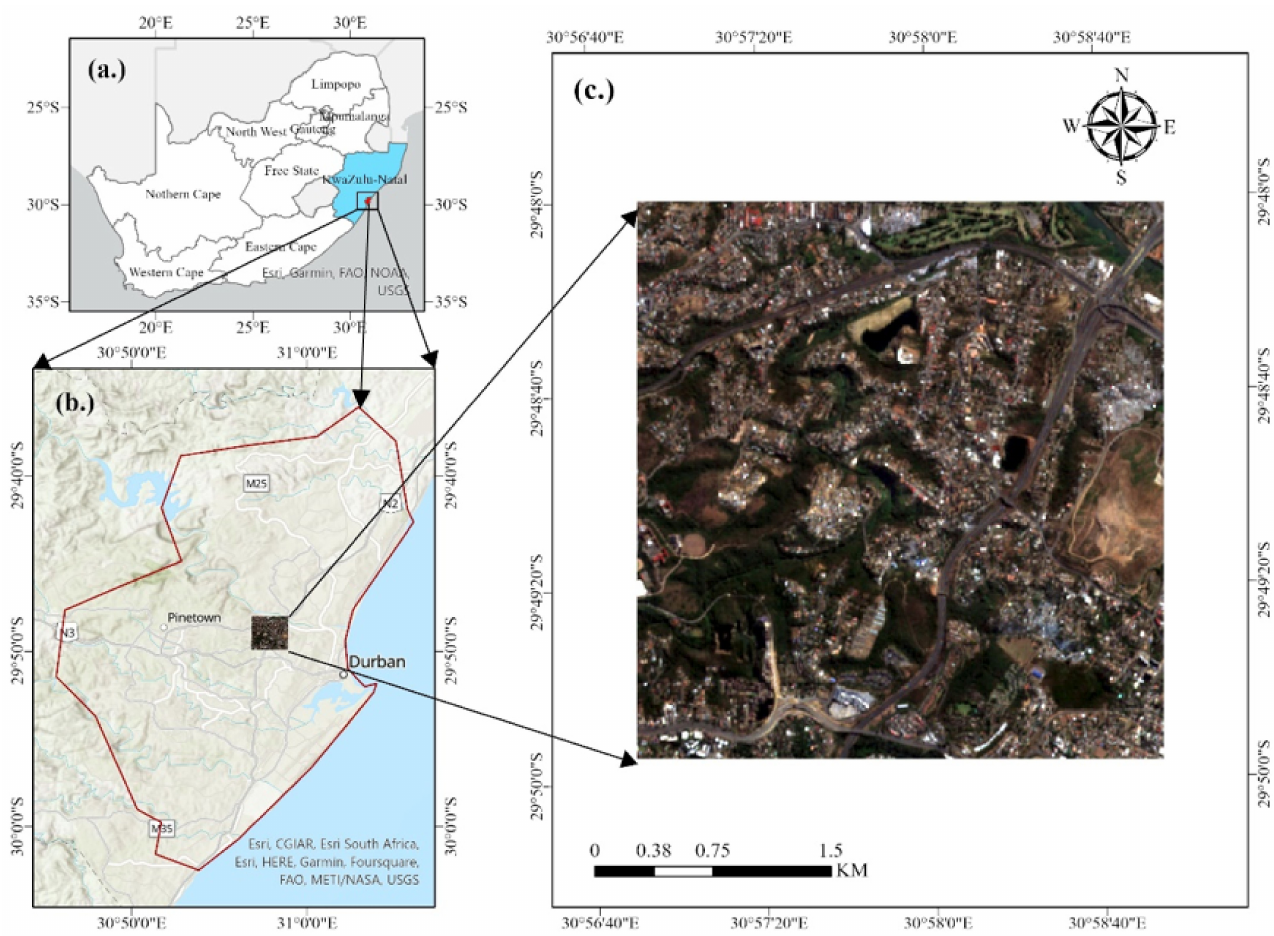
Figure 1. Study area selected in KwaZulu-Natal province ( a ), within Durban Metropolis ( b ), South Africa. ( c ) is the RGB overview of the Sentinel 2A imagery, in UTM/WGS84 plane